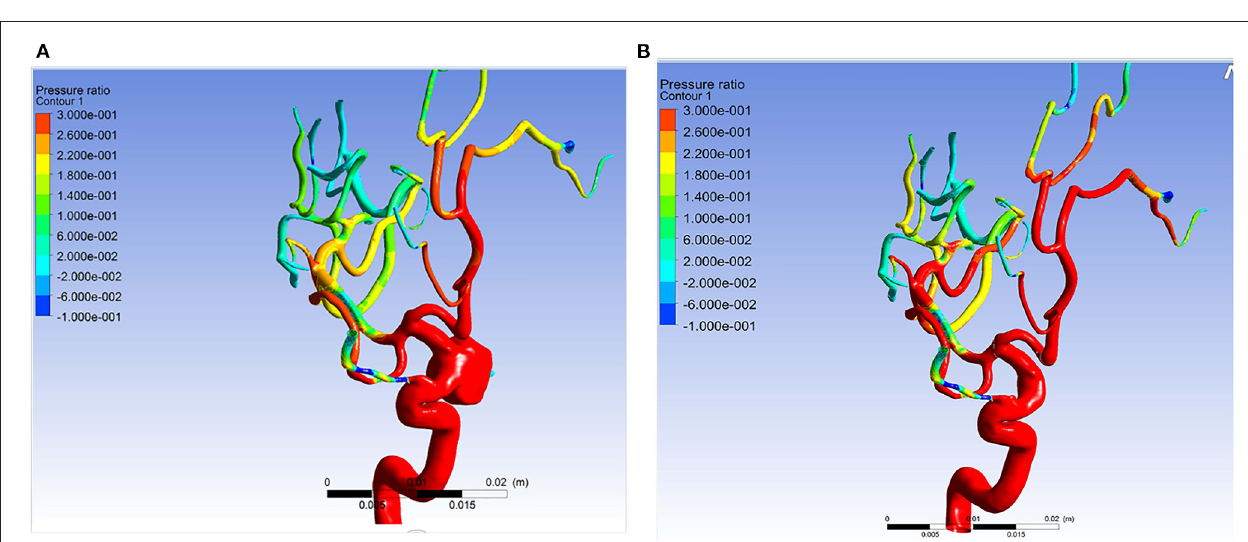
Frontiers in Neurology |